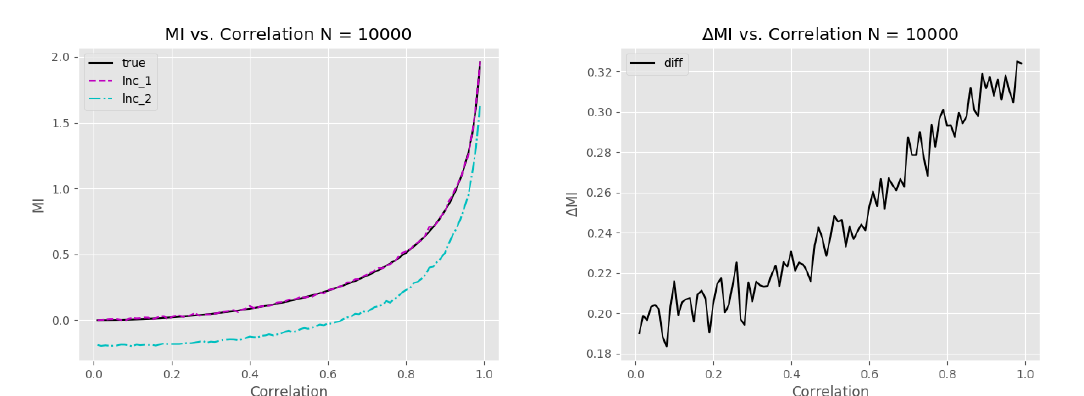
Figure 2. Comparison of mutual information estimates LNC for a bivariate normal distribution before (lnc_1) and after (lnc_2) a linear transformation of one variable by a factor of 10 5 . The second plot shows the difference between (lnc_1) and (lnc_2).